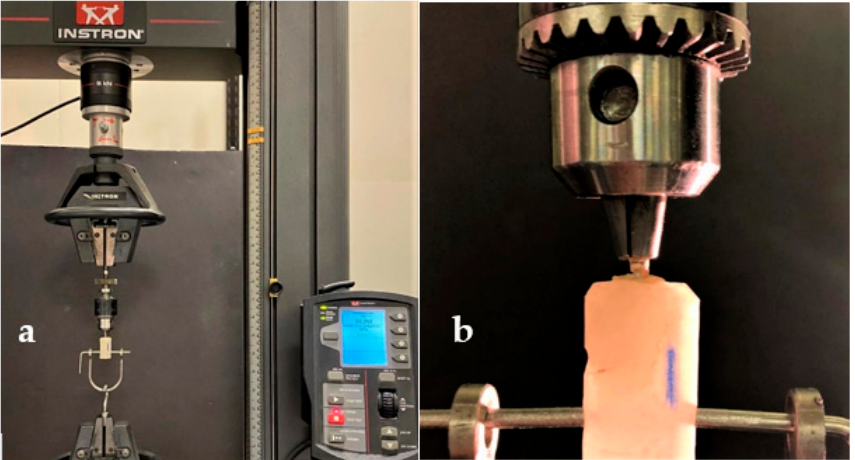
Figure 4. ( a ) Samples attached to the Instron testing machine; ( b ) Close up view of the pneumatic grips that grasped the post head and pulled the post along its long axis.